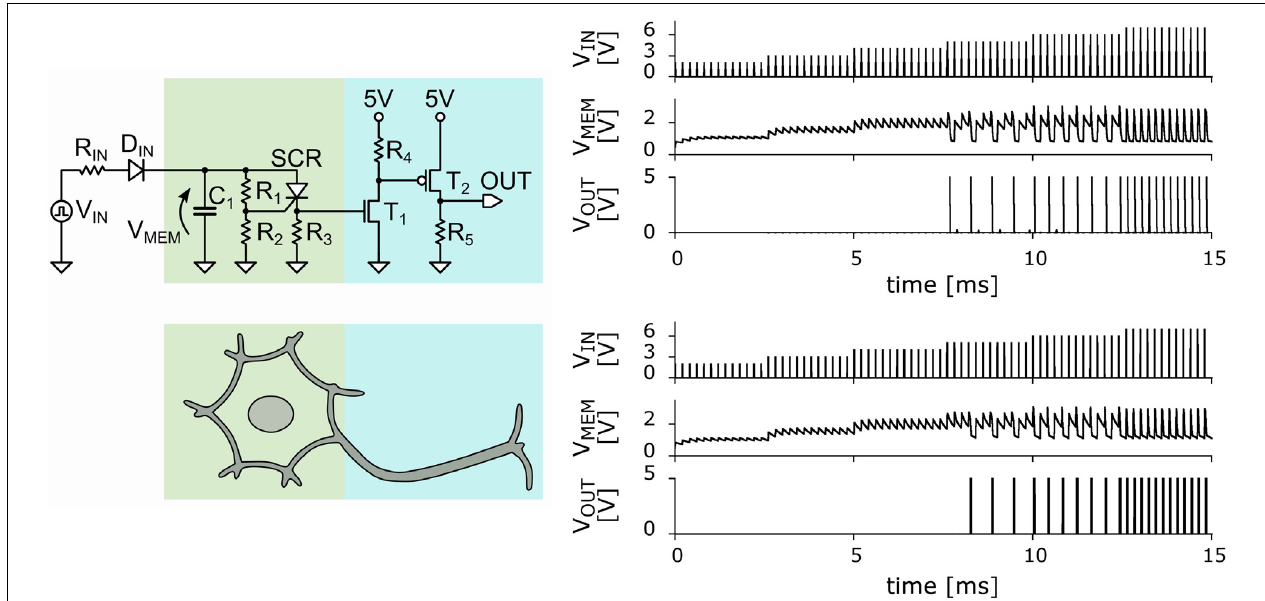
FIGURE 1 | Left panels: Basic circuit of the ultra-compact LIF neuron. The portion of the circuit representing the cell body or soma is in green, and that representing the axon is in blue (Rozenberg et al., 2019). Right panels: Comparison of the measured (top) and simulated (bottom) basic LIF spiking behavior of the neuron circuit. V IN (measured in volts) denotes the incoming applied voltage pulses from the voltage pulse generator as function of time (in milli-sec). V MEM denotes the voltage at the “membrane” capacitor as function of time. V OUT denotes the output voltage showing a spiking pattern. The existence of a threshold value of V IN for the spiking behavior is clearly observed. It is also observed that as incoming voltage is increased the output spiking rate increases. The agreement between measured data and the simulations is excellent, with the exception of a small transient near the threshold input voltage